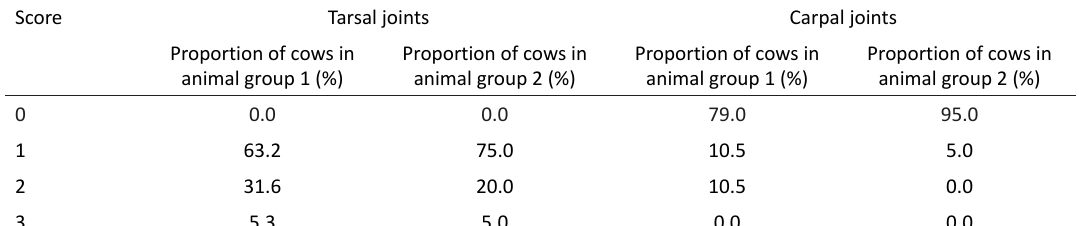
Table 3. The proportion (%) of cows in different classes of integument alterations in the two observed animal groups at the beginning of the experiment (baseline situation).